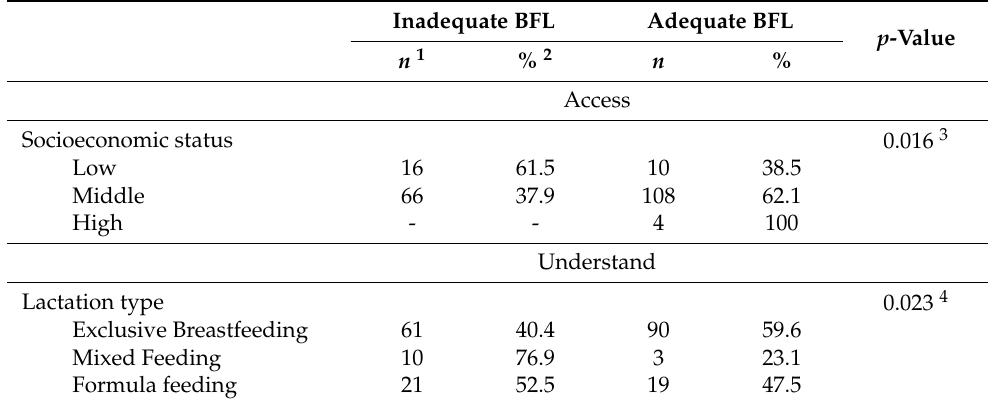
Table 6. Statistically significant associations with the dimensions of the BLAI